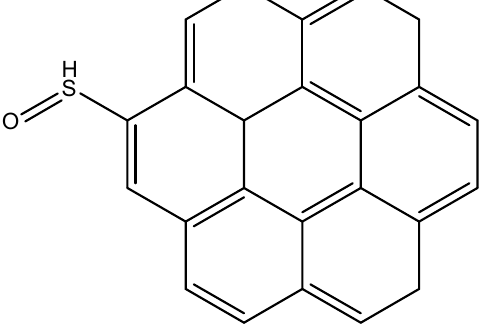
Scheme 2. Example of sulfated “heavy” coke Scheme 2 : example of sulfated "heavy" coke molecule.